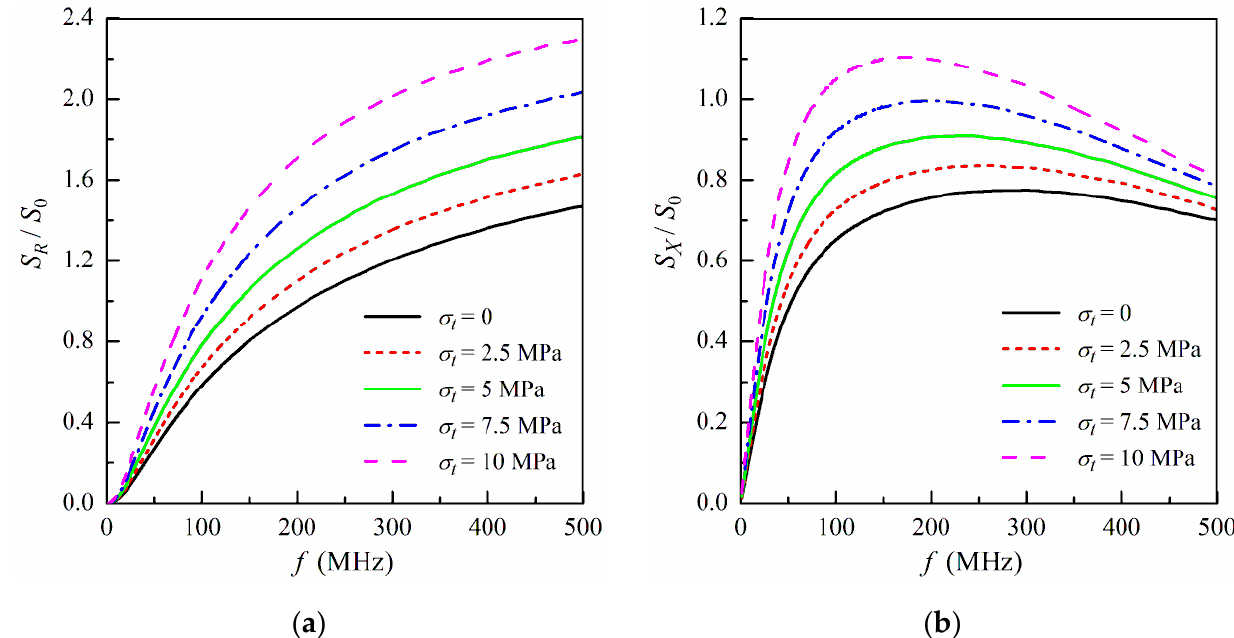
Figure 7. The field sensitivity of the real part S R ( a ) and imaginary part S X ( b ) of the ODMI as a function of the frequency f at I b = 30 mA for different values of the tensile stress σ t . Magnetostriction coefficient λ s = 40 × 10 − 6 , other parameters used for calculations are the same as in Figure 3.